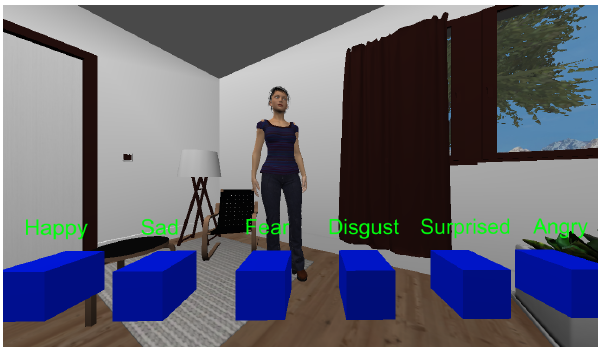
Figure 2. ‘Yes’ and ‘No’ buttons.